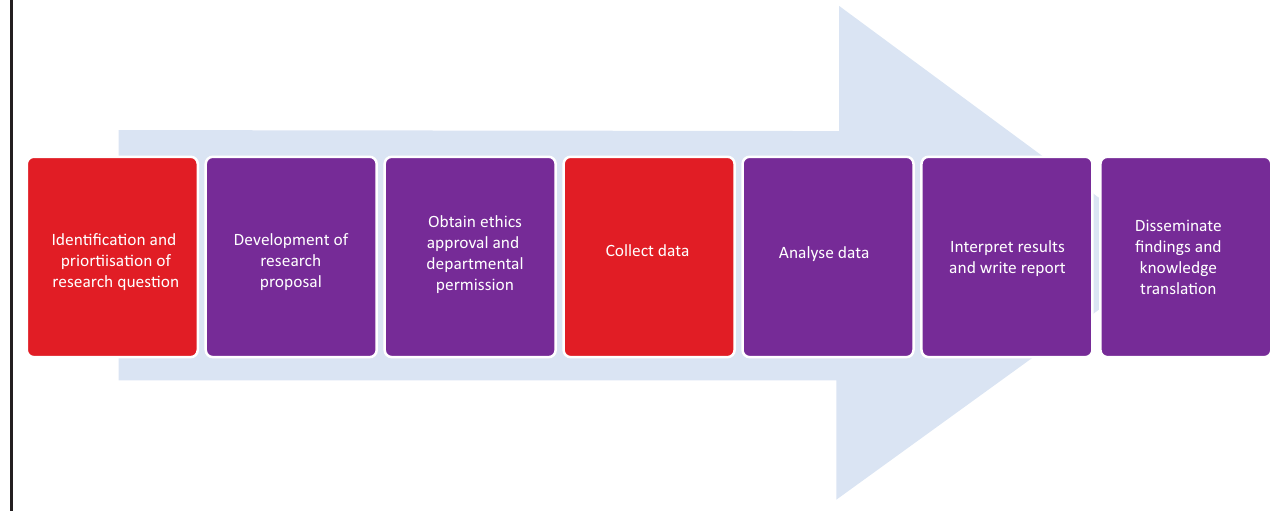
FIGURE 1: Steps in the research